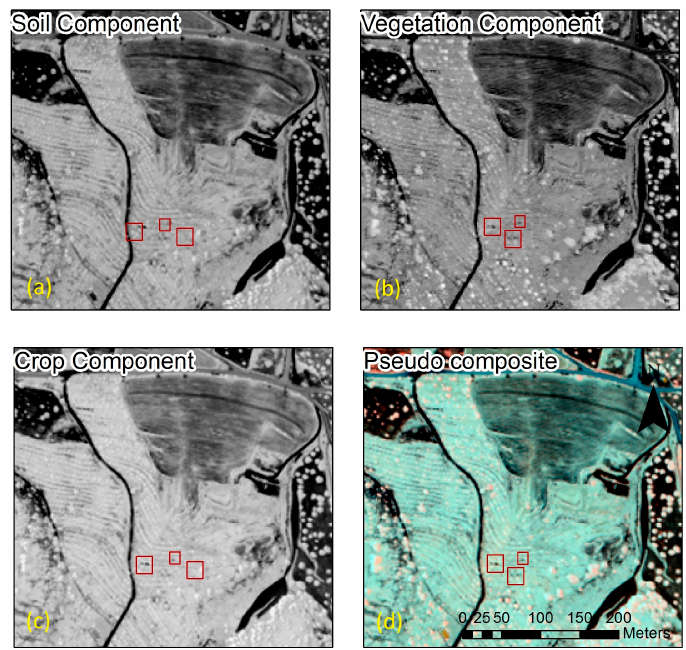
Figure 10. WorldView-2 spectral reprojection in a new 3D space: ( a ) soil component, ( b ) vegetation component, and ( c ) the crop mark component are shown in greyscale. The RGB pseudo-composite ( d ) of these three components is also shown in the lower right (soil component, vegetation component, and crop mark component reflect the red, green, and blue bands, respectively).